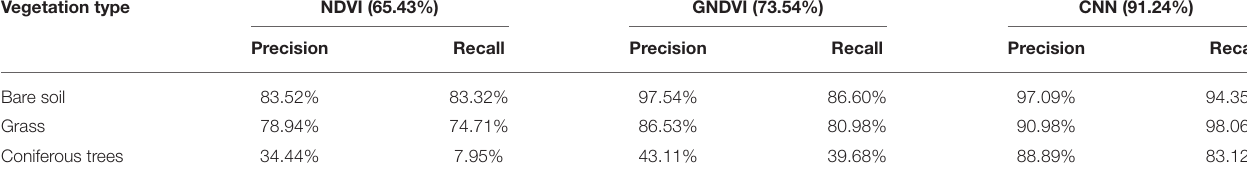
TABLE 4 | The comparison of precision and recall of three methods. Vegetation